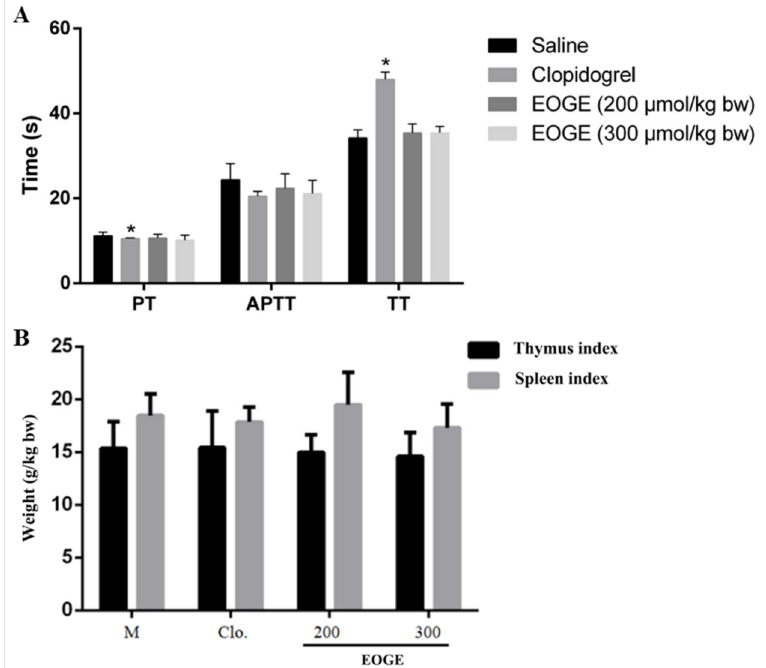
Figure 5. Effects of EOGE on ( A ) PT, APTT, and TT, and ( B ) thymus index and spleen index in rats. Male Sprague Dawley rats were orally administrated with 0.9% saline, clopidogrel, EGOE at different doses ( µ mol/kg b.w.), respectively. * indicates p < 0.05 as compared to the M group ( n =